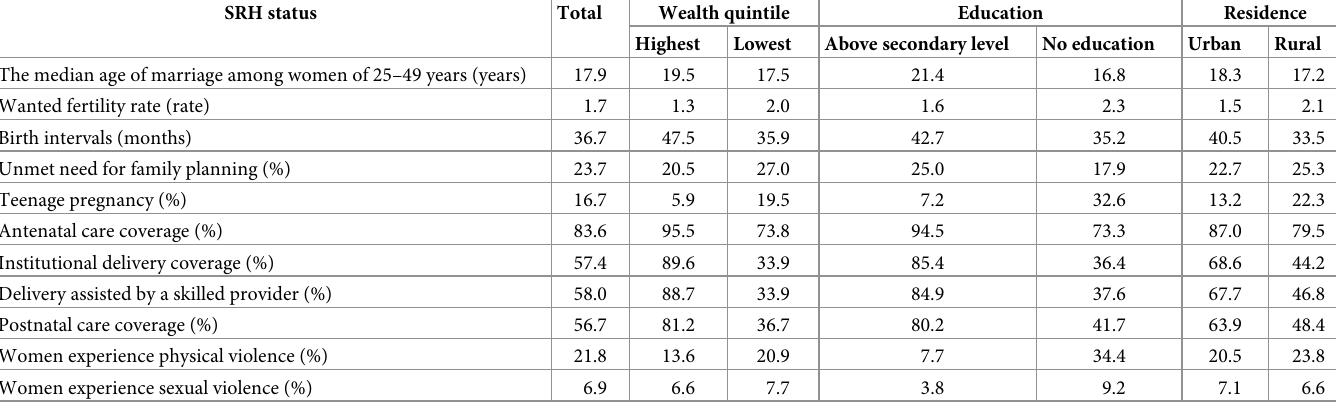
Table 1. Overview of SRHR status in Nepal by background